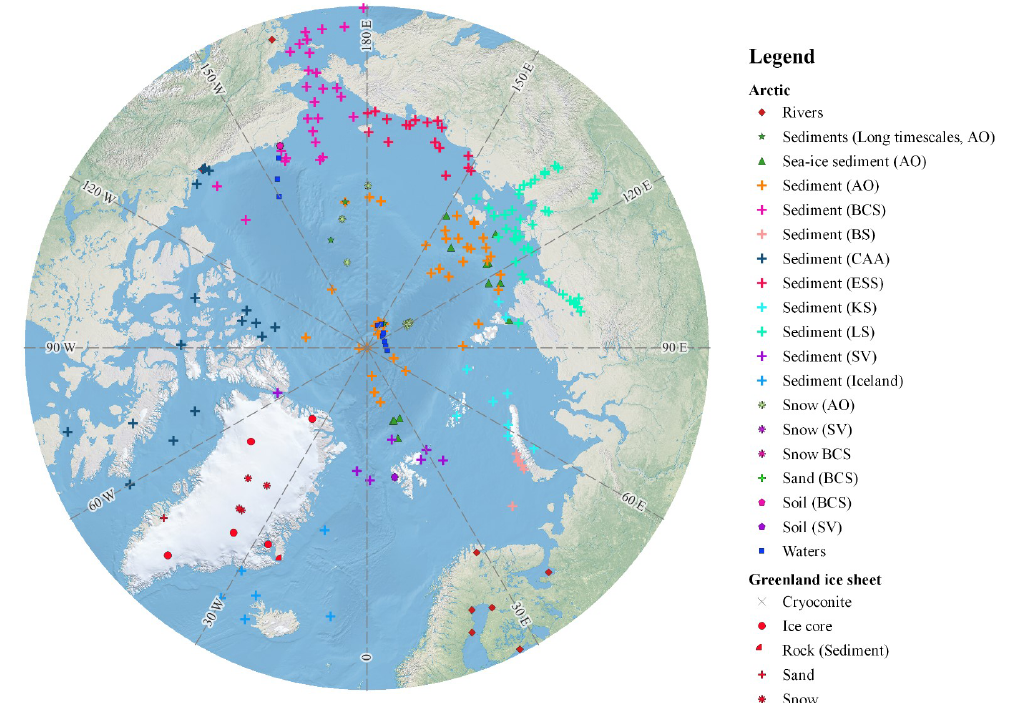
Figure 4. Distribution of sampling sites in the Arctic. The types of samples are denoted using different shapes and colors (see legend; Table 3). The abbreviations used in the figure are as follows: AO – Arctic Ocean, BCS – Bering–Chukchi Sea, BS – Barents Sea, CAA